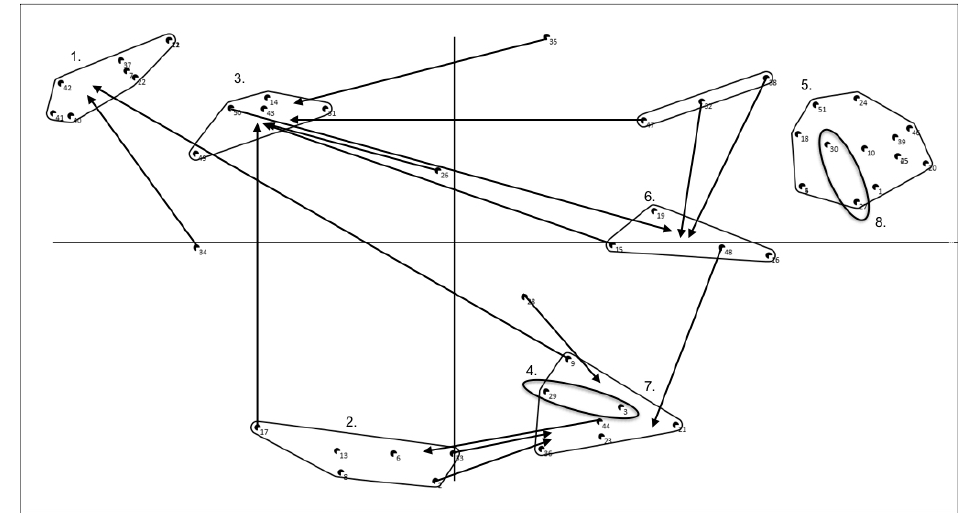
Figure A3. Concept map children (school 4). Note that points, i.e., statements, sorted more often together appear closer to each other, and statements never/rarely sorted together appear widely separated; Arrows indicate a statement is reallocated by researchers, circles indicate a new cluster is created by researchers as a result of reallocation of statements; Cluster 1: I sit because it is the norm/I sit because I have to; Cluster 2: I sit because I want to make contact with my friends; Cluster 3: I sit because I can work/play better that way; Cluster 4: I sit because there is nobody to play (actively) with; Cluster 5: I sit because I’m tired, I want to relax, I want to rest; Cluster 6: I sit because the physical environment is not suitable; Cluster 7: I sit because seated activities are fun; Cluster 8: I sit because there is nothing to